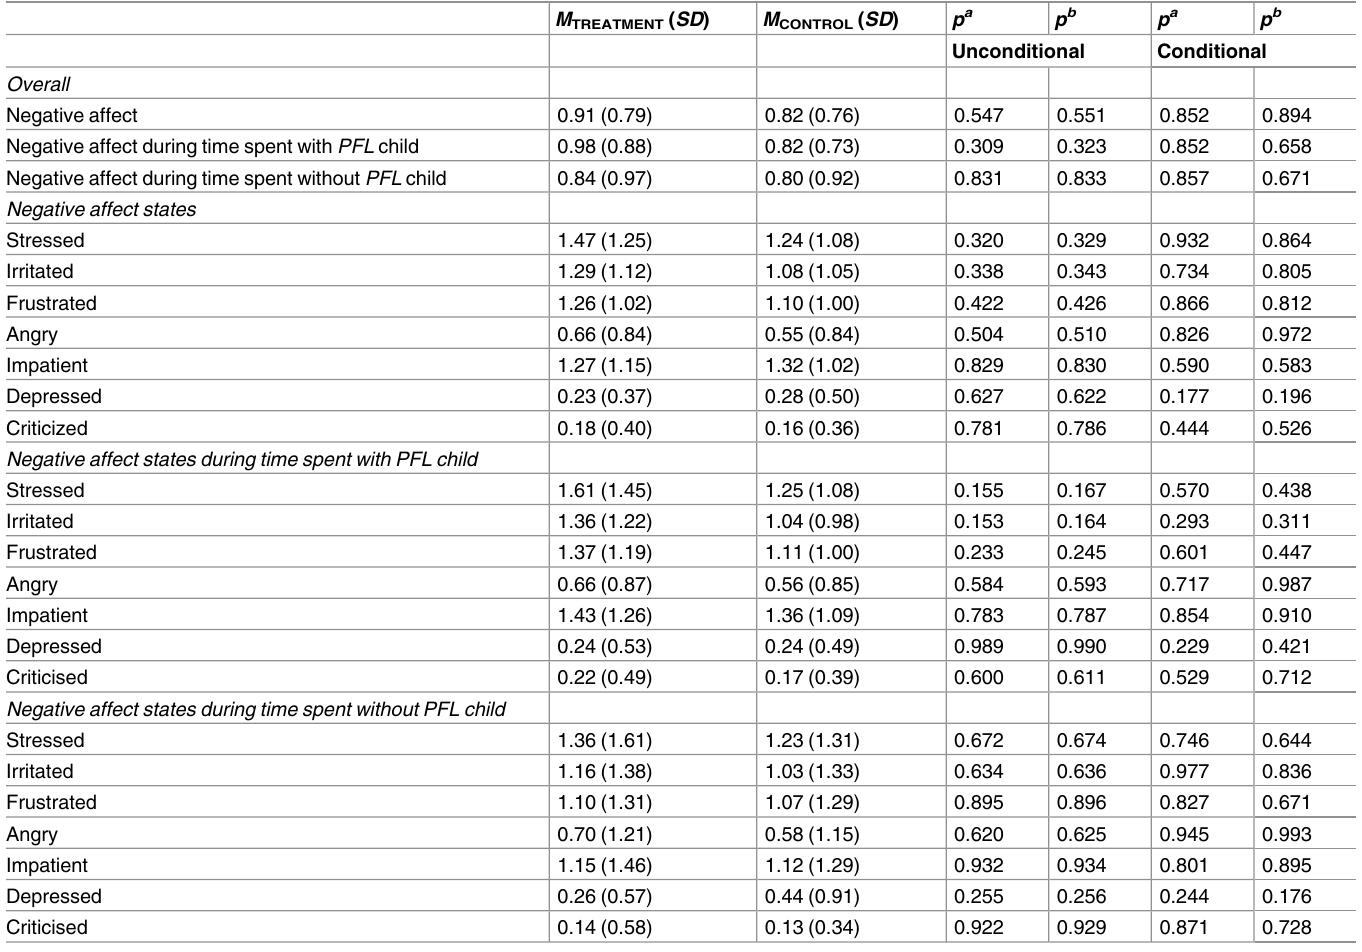
Table 3. Treatment Effects for Experienced Well-being: Negative